Question: Sum up the contents of this chart in one sentence.
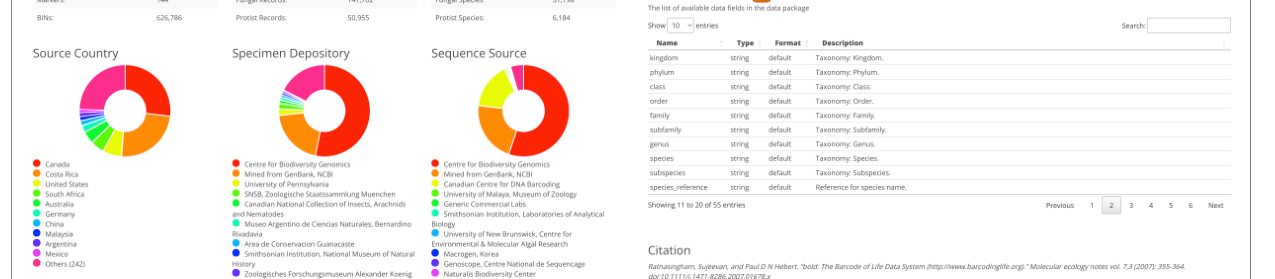
Answer: The data package for the BOLD library for December 31, 2022 shows the following key  features: (1) Digital Object Identifier; (2) Summary statistics, encompassing the number of records,  sequences, markers, and BINs; (3) Data dictionary.